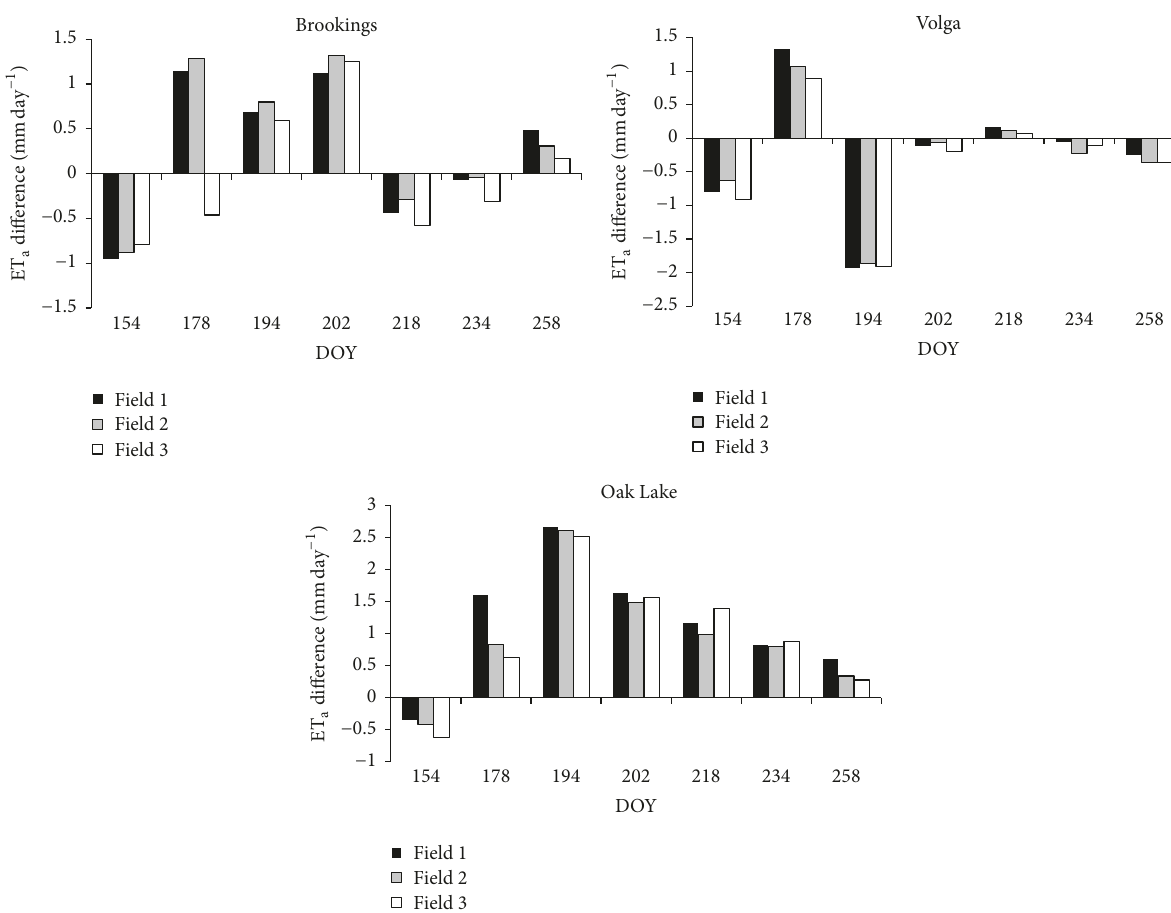
Figure 10: Daily ET